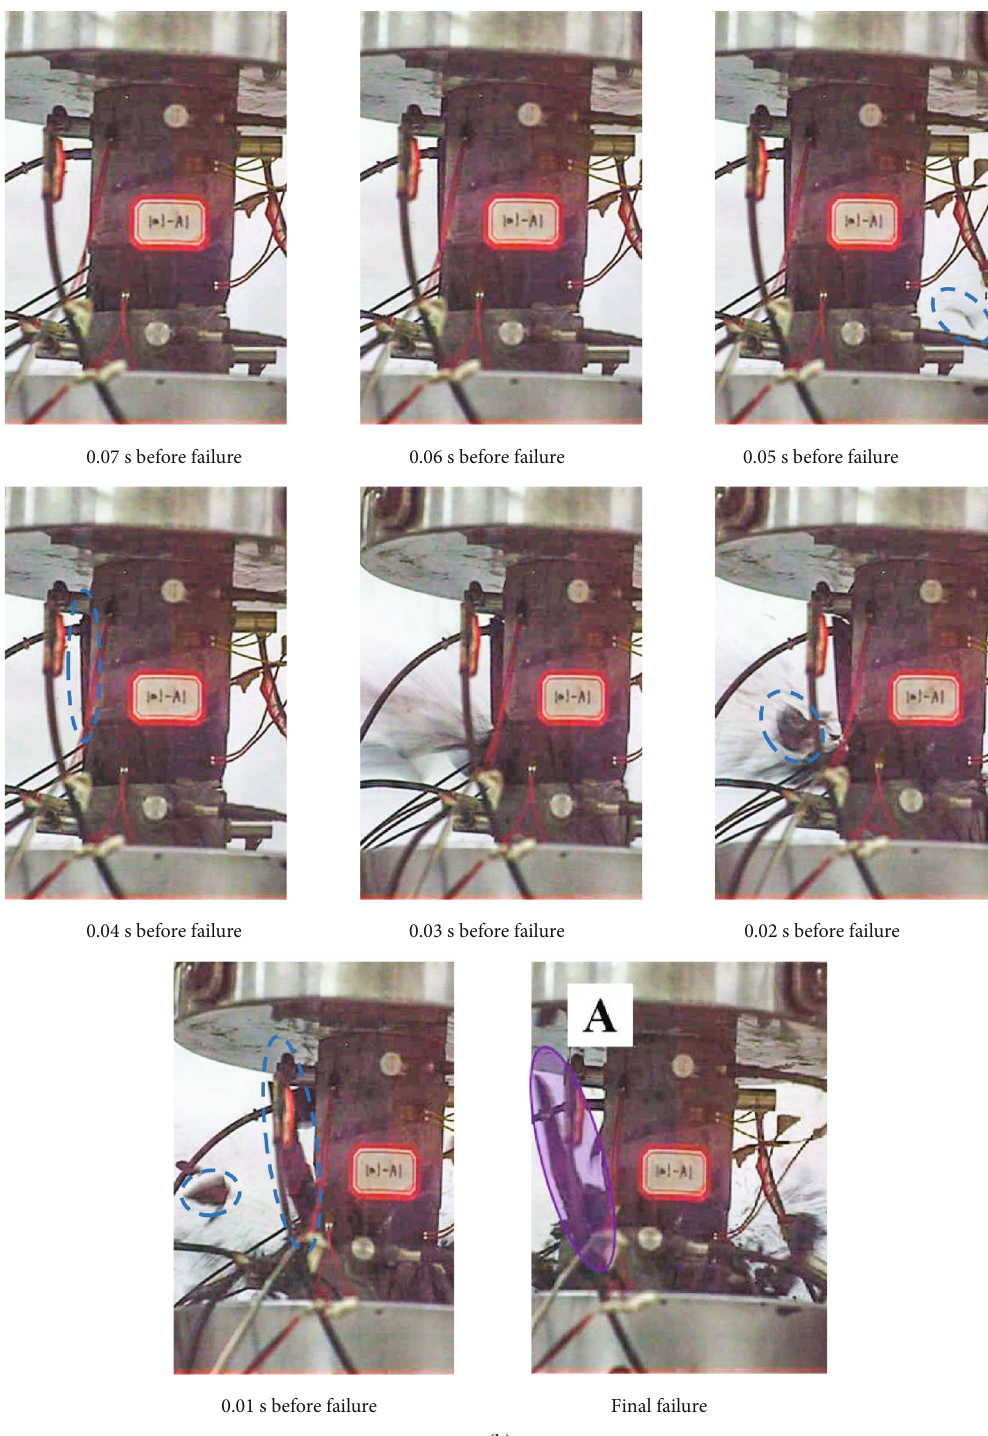
Figure 12: (a) Spatial distribution of AE events for each stress level of the 1a1-A1 specimen. (b) Failure process of 1a1-A1 specimen captured by high-speed